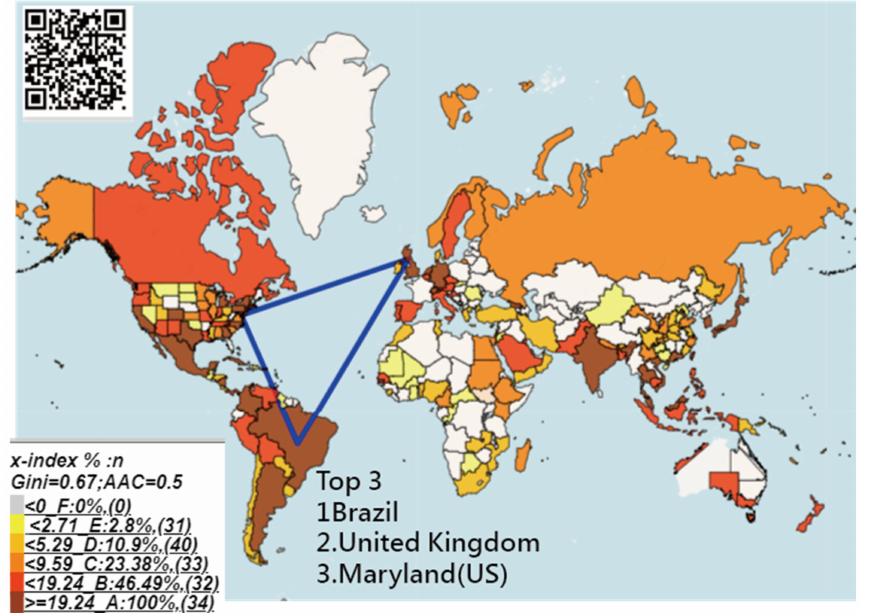
Figure 4. Research contributions as measured by x-indexes for articles regarding countries/areas in abstracts around the world; the darker means higher x-index and more contributions to the dengue